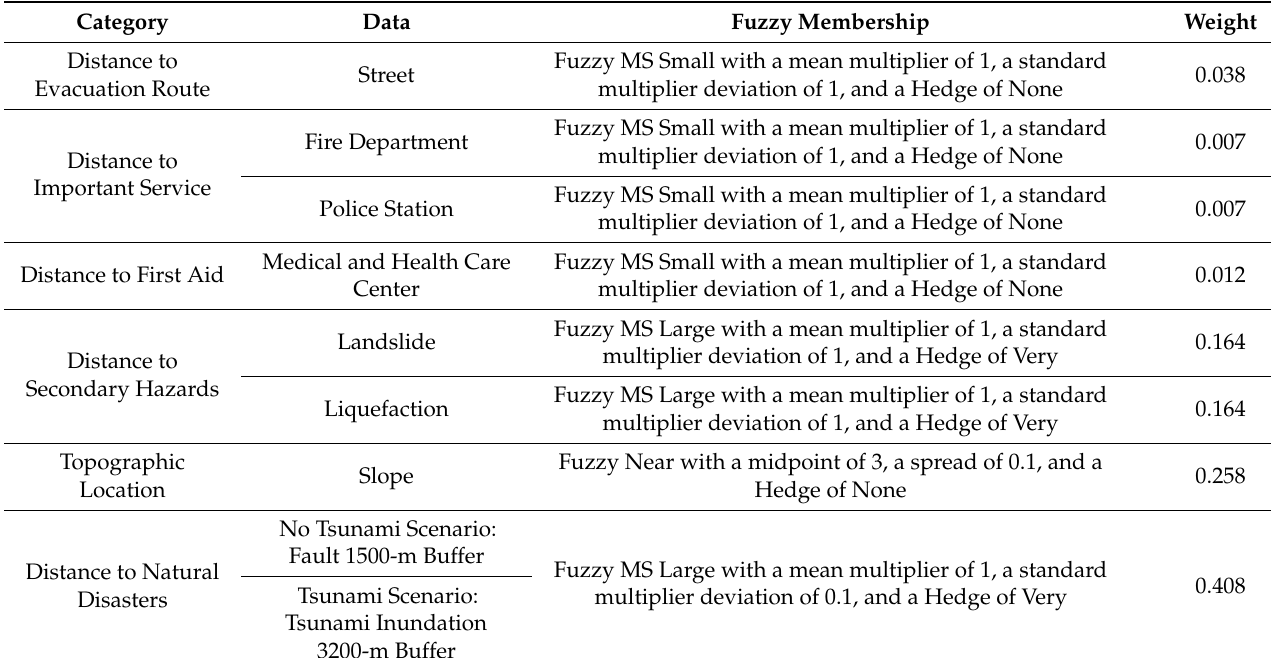
Table 2. Fuzzy functions and overlay weights in the suitability